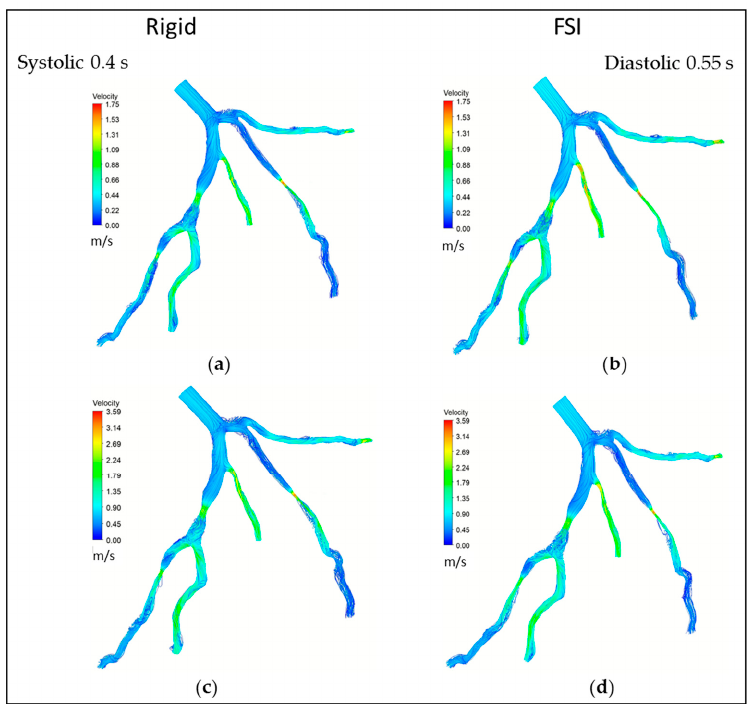
Figure 9. Velocity streamlines of the blood flow field in the left coronary artery (LCA) during the systolic and diastolic phase of cardiac cycle for ( a , c ) rigid and ( b , d ) FSI models.